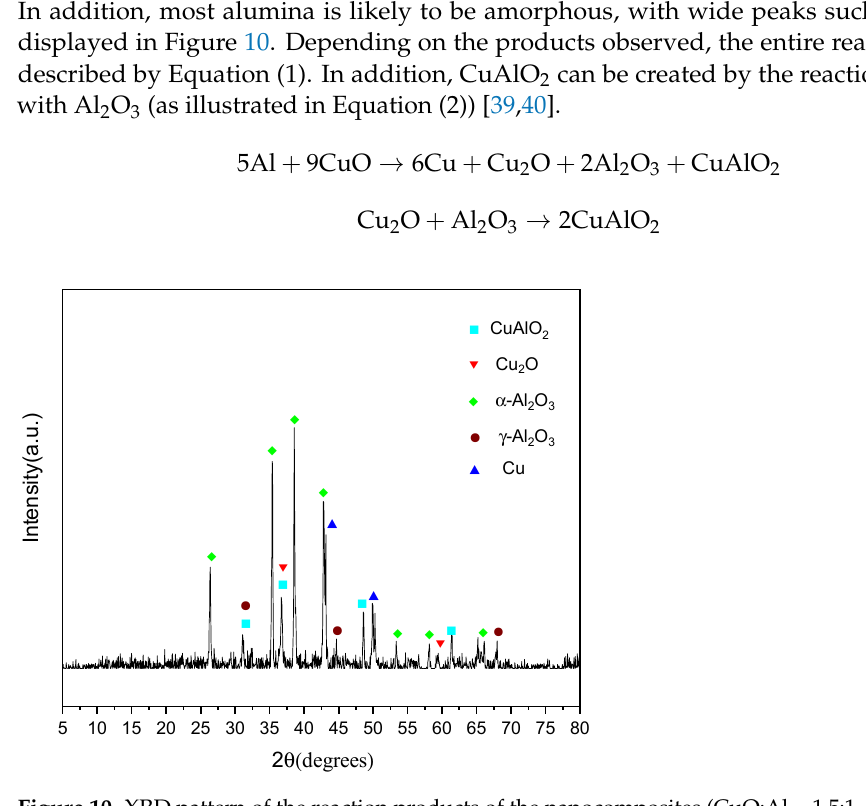
Figure 9. XRD pattern of the reaction products of CuO–GO.